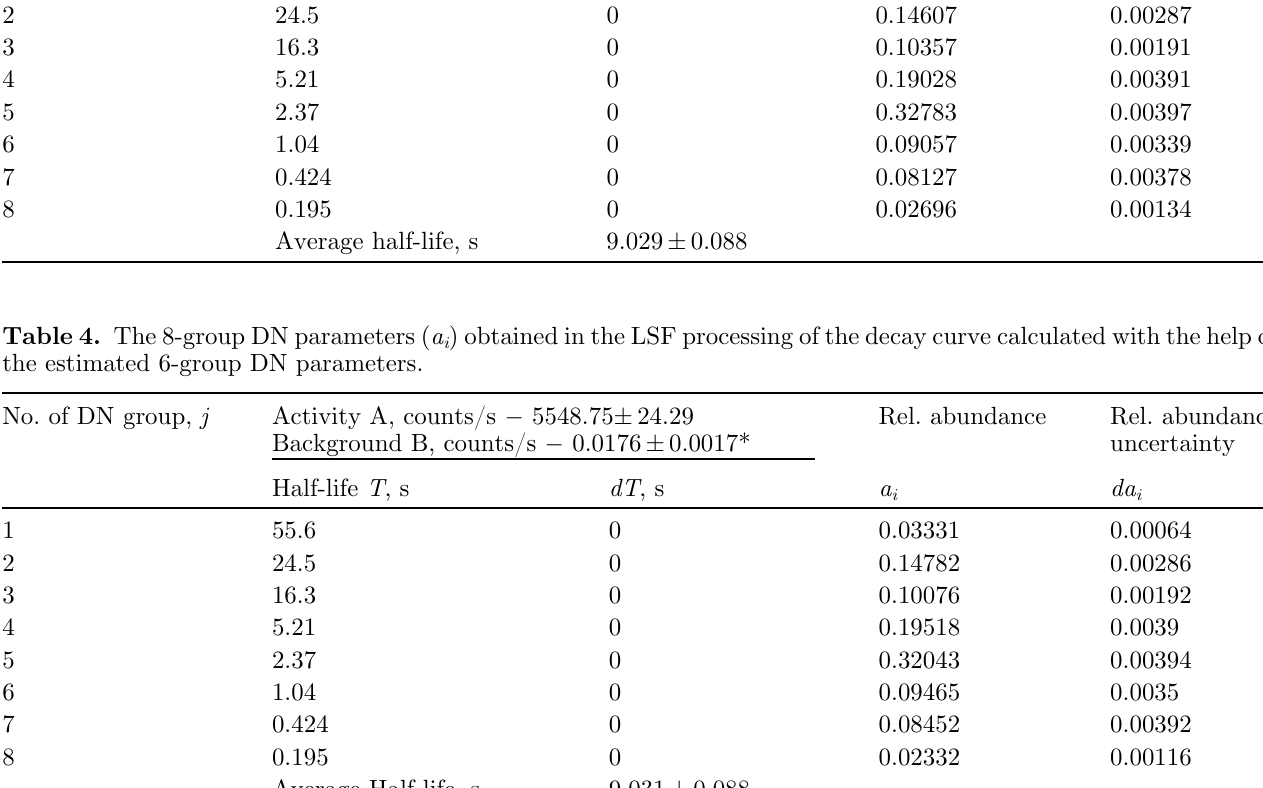
) obtained in processing of the experimental decay curve measured from fi ssion i